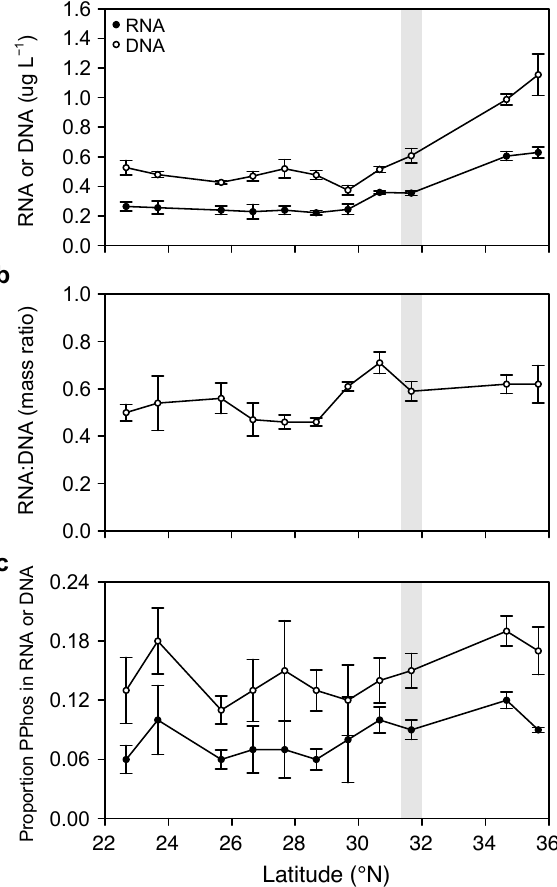
Fig. 3. Allocation to nucleic acids as a function of latitude across the BV47 cruise transect (see Fig. 1). Shaded region represents the approximate location of BATS. All points represent means ±